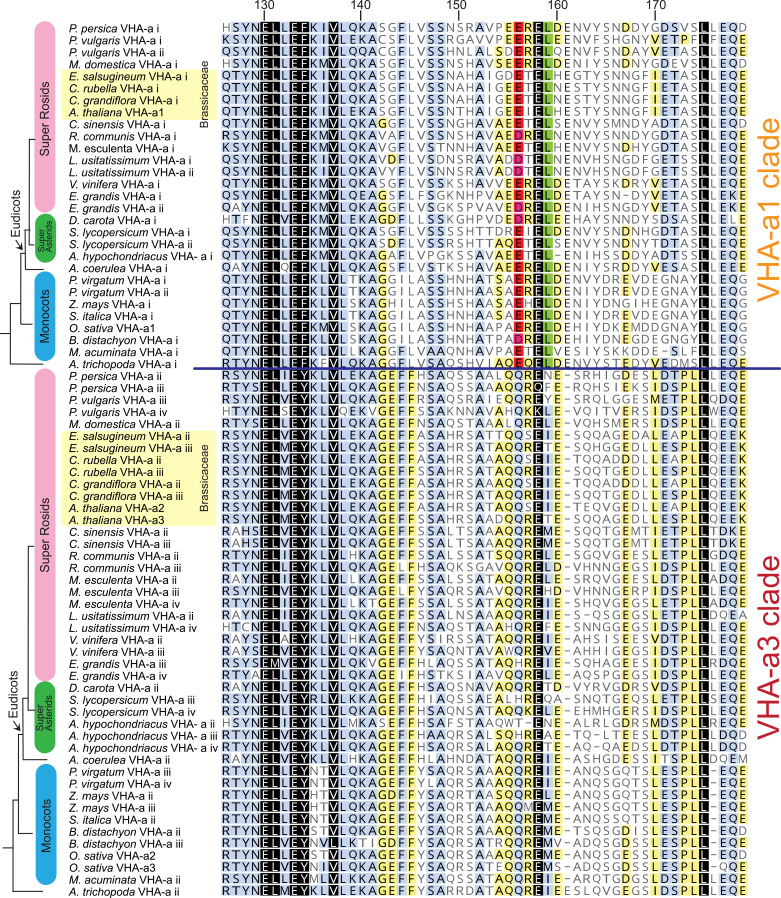
The VHA-a1-TD is conserved in Angiosperms.Amino acid sequence alignment of representative sequences from the VHA-a1 and VHA-a3 clades. The sequence numbers are in reference to the A. thaliana VHA-a1 sequence. Residues highlighted in black, blue and yellow are 100%, 80–100% and 60–80% similar, respectively. Un-highlighted residues are less than 60% similar. The alignment is restricted to the VHA‐a1 targeting domain (His126 to Glu 179 in A. thaliana VHA-a1). The alignment reveals that there is an acidic cluster that is only present in the VHA-a1 clade.